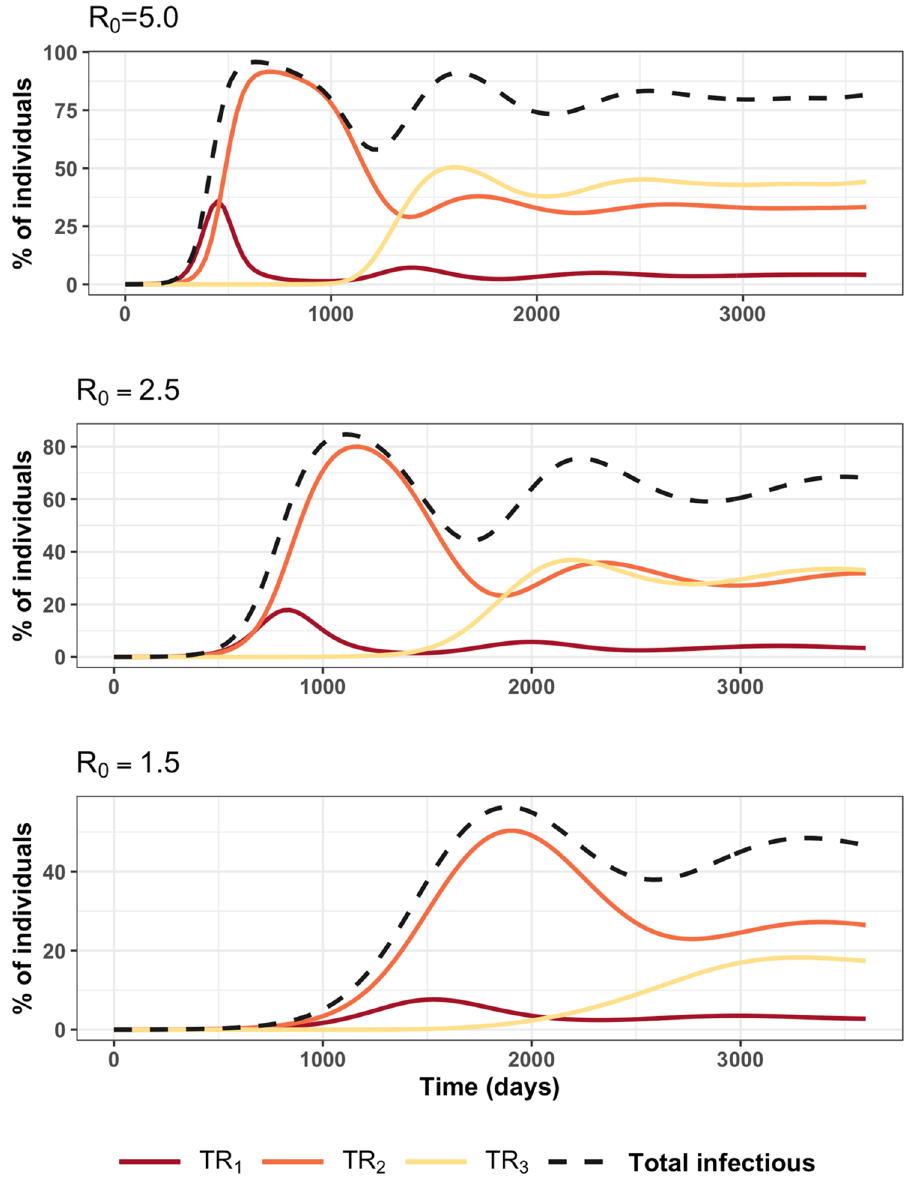
Figure 3. Average proportion of antibody positive animals of type “ i ” from the diagnostic test ( TR 1 , carrying IgM and IgG antibodies; TR 1 , only carrying IgG and TR 3 carrying high-level of IgG) for 10 years. Proportion = 100 × number of animals/total population; with total population =